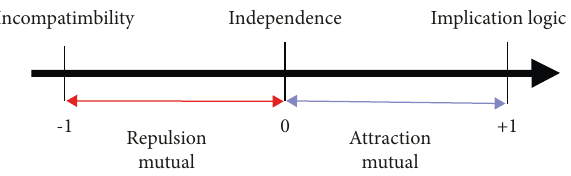
Figure 2: Reference situations of the measure OR pulsion, mutual